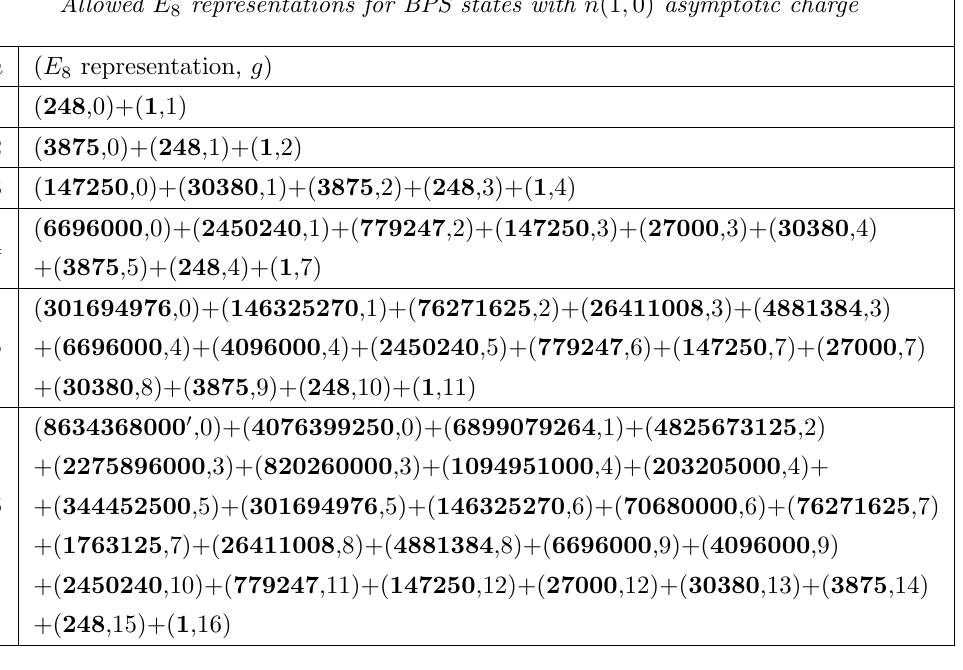
Table 5 . The allowed representation for BPS states with asymptotic charges n (1 ; 0), with 1 (cid:20) n (cid:20) 6 are listed. We also keep track of the genus of the corresponding holomorphic